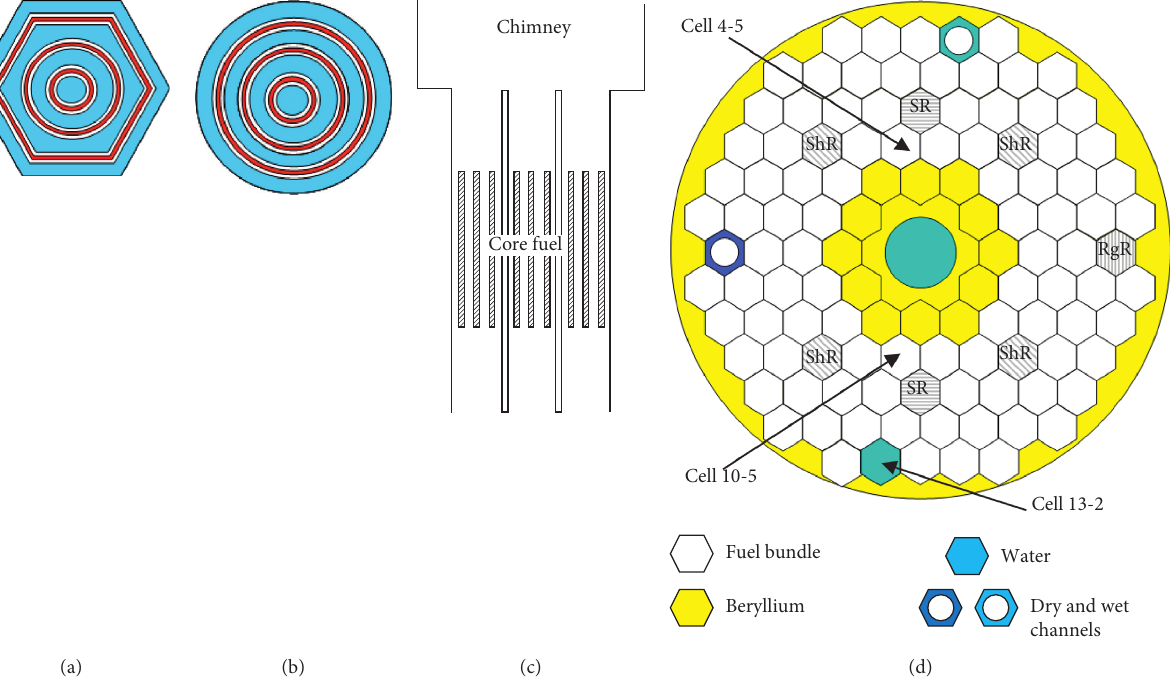
Figure 4: The DNRR model calculation for the PLTEMP/ANL code and LEU core with 92 FBs. (a) Fuel bundle cross-section. (b) Fuel bundle cross-section model. (c) Reactor coolant system model for PLTEMP/ANL code. (d) LEU working core with 92 FBs.